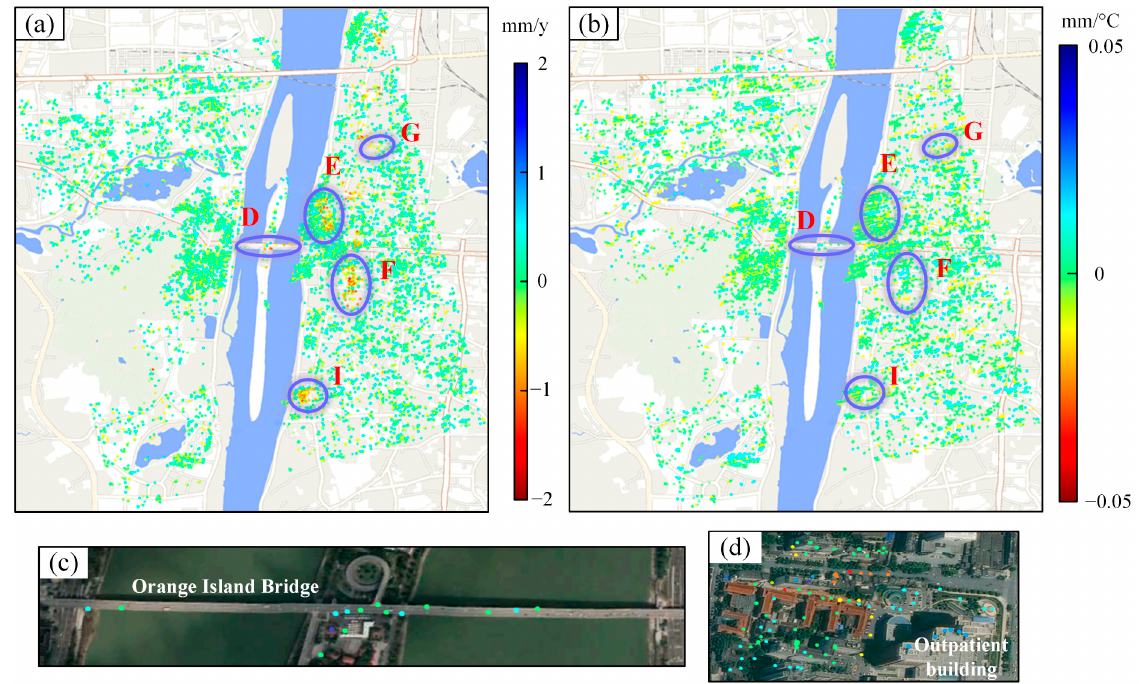
Figure 8. ( a ) Annual velocity map. ( b ) Thermal expansion coefficient map. ( c , d ) These are enlarged maps of areas D and G in Figure 8b (with an optical image as the background; E represents the area near Wanda Plaza; F represents the area near International Finance Square building; I represents the area near Poly International Plaza).